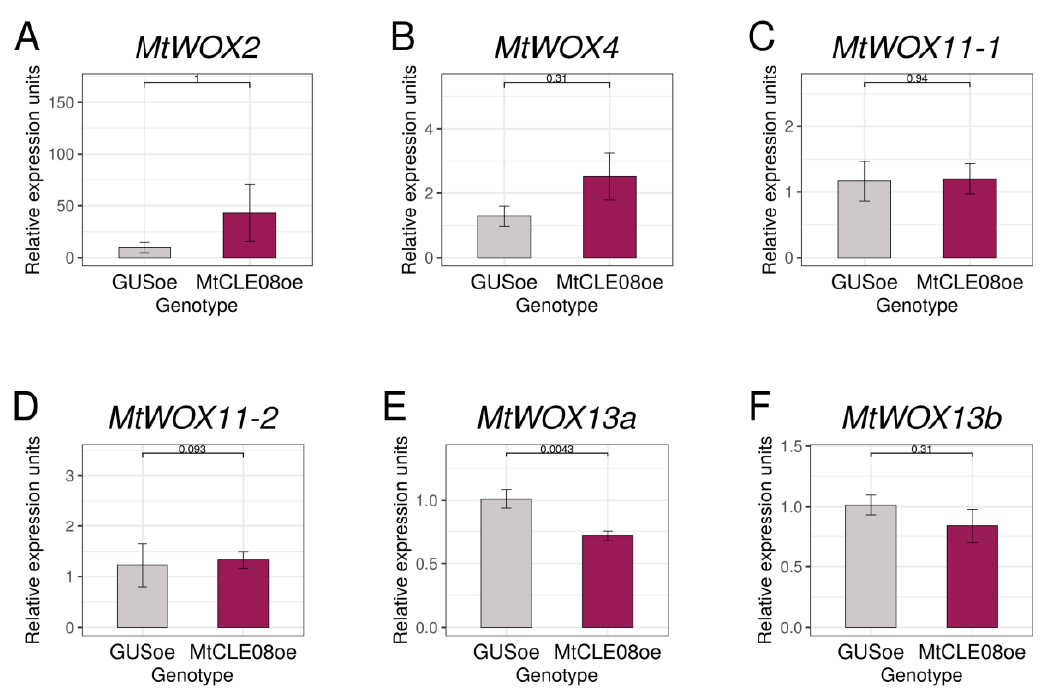
Figure 6. Expression levels of the MtWOX2 ( A ), MtWOX4 ( B ), MtWOX11-1 ( C ), MtWOX11-2 ( D ) , MtWOX13a ( E ) and MtWOX13b ( F ) genes in transgenic calli with GUS and MtCLE08 overexpression. Error bars represent the standard error. Data are obtained from 6 biological repeats per genotype. To assess the statistical significance of the observed differences between different genotypes of calli, the Wilcoxon signed-rank test was used. Material for gene expression analysis in T0 calli was taken at 43rd–56th day after transformation, after 33–50 days of cultivation on the callus induction medium and 7–14 days of cultivation on the hormone-free medium.